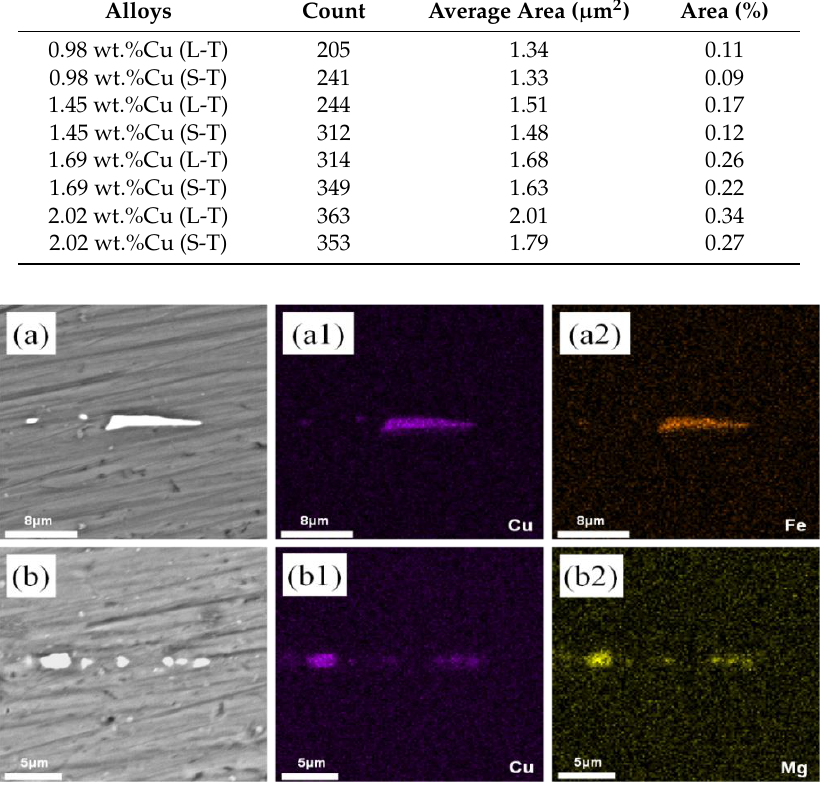
Figure 4. EDS element spectrum of the second phase for 2.02 wt.%Cu alloy: ( a , a1 , a2 ) Al 7 Cu 2 Fe; ( b , b1 , b2 ) Al 2 CuMg.